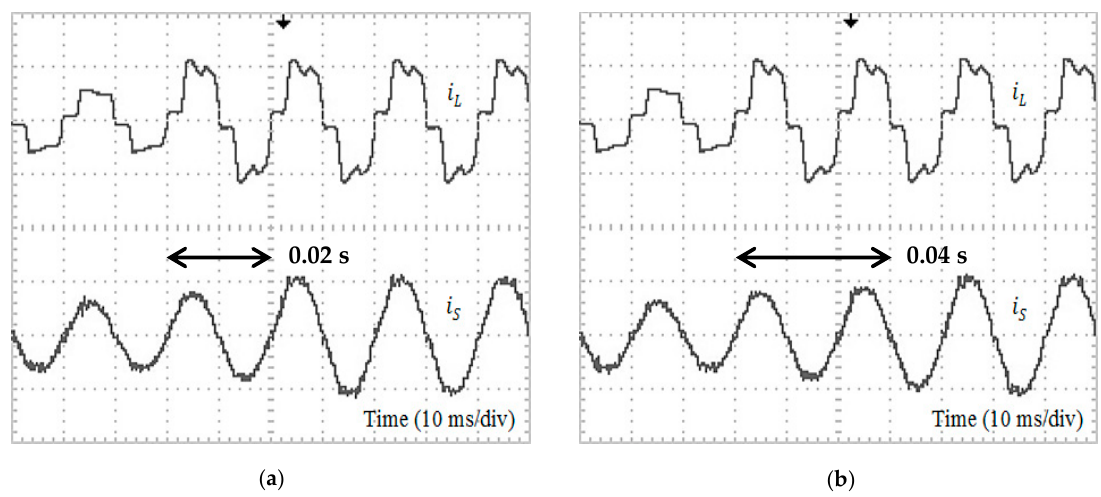
Figure 13. Experimental waveforms (Phase A) for dynamic-state condition of inductive to resistive which includes load current i L (5 A/div) and source current i S (5 A/div) resulted from SAPF utilizing